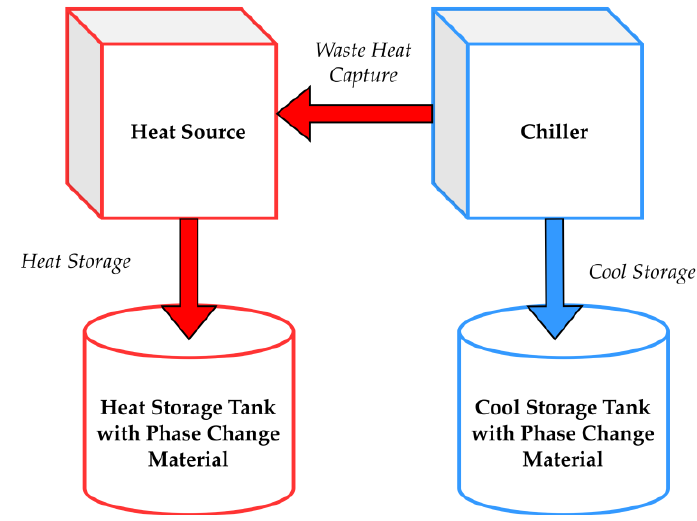
Figure 6. The main elements of a thermal energy storage system.